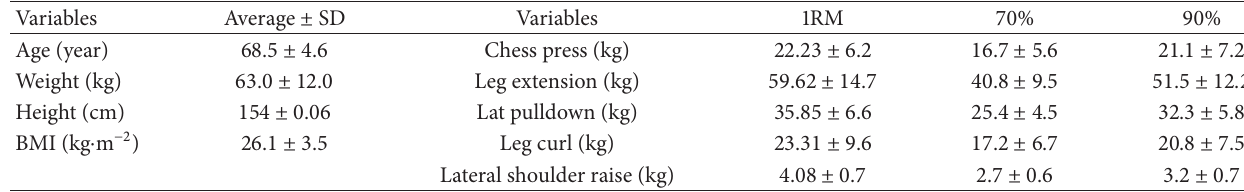
Table 1: Anthropometric variables, 1RM tests, and training loads.